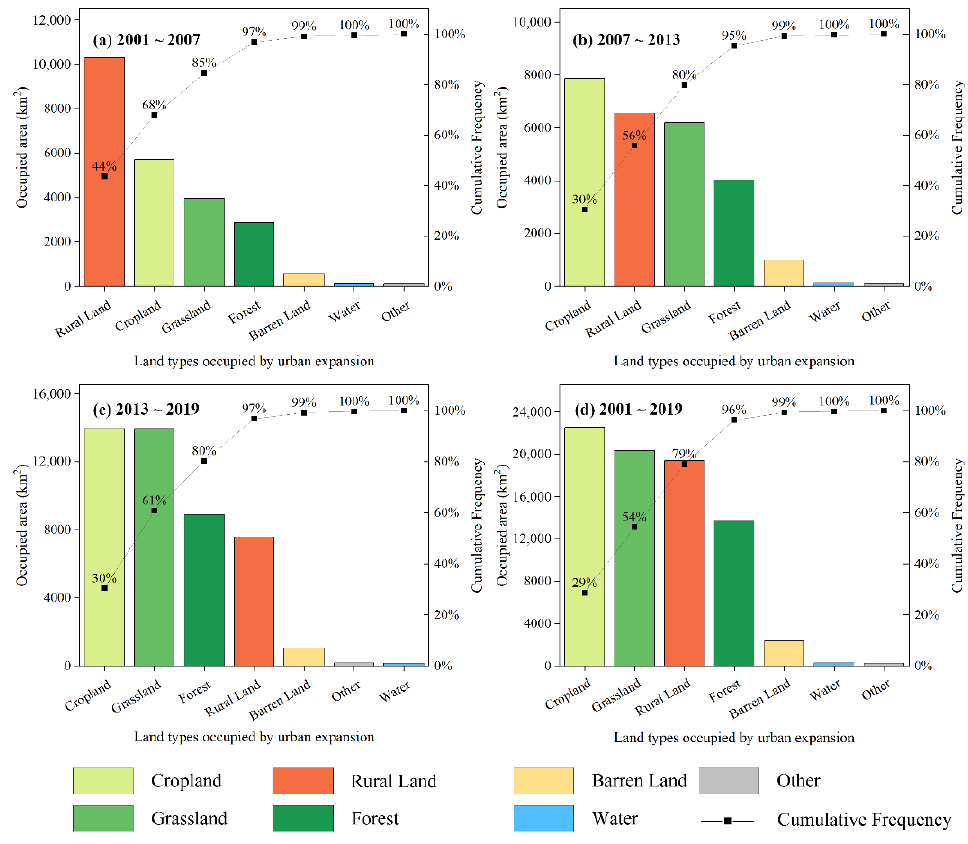
Figure 13. Pareto chart of other land types occupied by urban expansion in different periods.